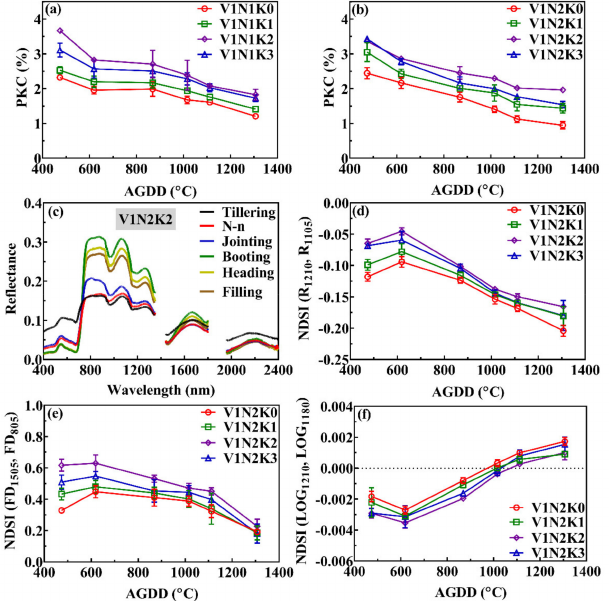
Figure 3. The variations pattern of rice plant potassium content (PKC) (N1 ( a ), N2 ( b )) and normalized difference spectral index (NDSI) based on reflectance spectra (R) ( d ), first derivative spectra (FD) ( e ), and reciprocal logarithm-transformed spectra (log (1/R)) ( f ), respectively, with different accumulated growing degree day (AGDD). Mean reflectance for selected V1N2K2 treatment with several growth stages ( c ). (For interpretation of the references to colour in this figure legend, the reader is referred to the web version of this article.) Note: Data of all figures used here were in 2017. V1 = japonica (Wuyunjing 27), N1 = 100 kg · ha − 1 , N2 = 300 kg · ha − 1